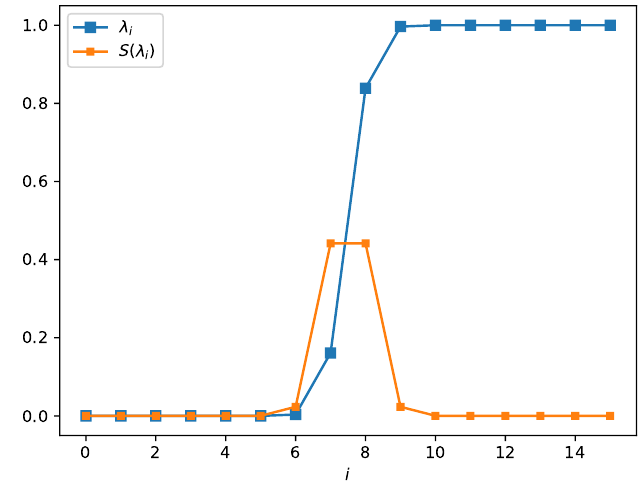
Figure 10: In blue the eigenvalues λ of the reduced state Λ (cid:96) = of the ground state i 16 ) of a hopping Hamiltonian with N = 500. In orange the von Neumann entropy S ( λ i of the mode associated to each eigenvalue λ . The total von Neumann entropy of the i partition Λ (cid:96) = is given by the sum of the entropies of each mode (see (89)). Since 16 the entropy of a partition Λ (cid:96) is bounded by log ( (cid:96) ) , with growing (cid:96) the added modes must have associated eigenvalues close to 0 or